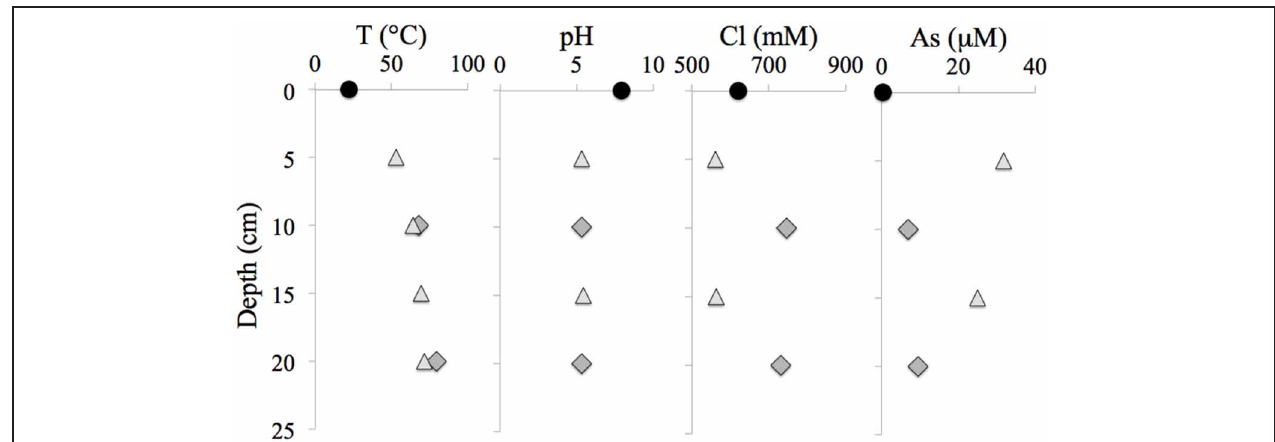
sites with respect to Cl and As concentration. Seawater values are indicated with a filled circle, RP data are indicated with a dark gray filled diamond, and TW data are indicated with a light gray filled triangle.